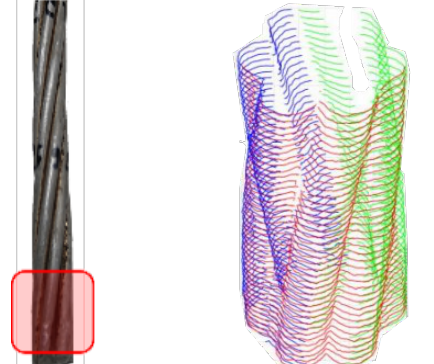
Figure 14: 6 mm diameter aluminium distribution cable – 40 sections with 0.34 mm between sections.